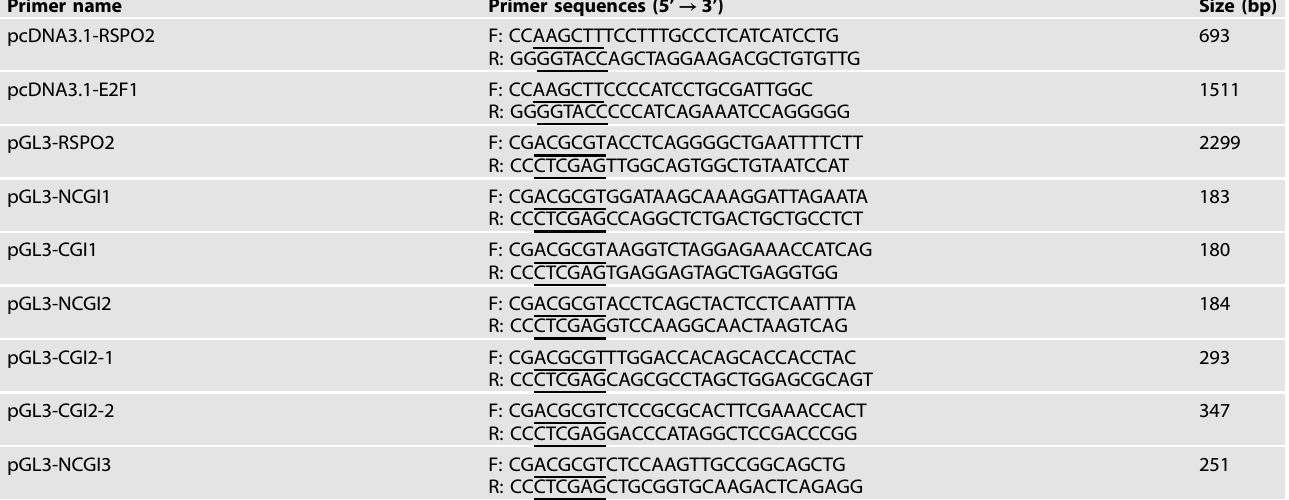
Table 3. Primers used for vector construction.